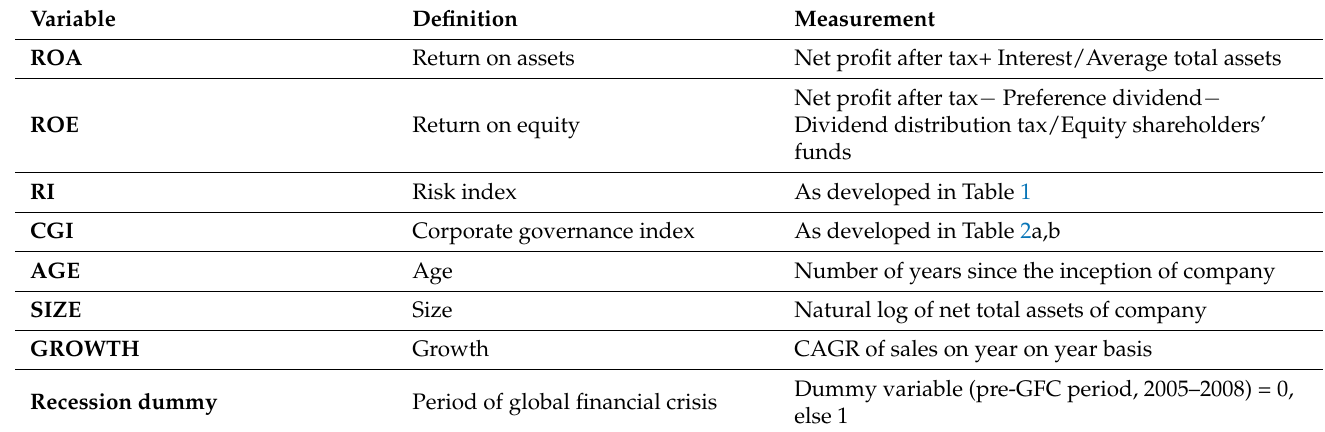
Table 3. Description of Variables and their measurement.